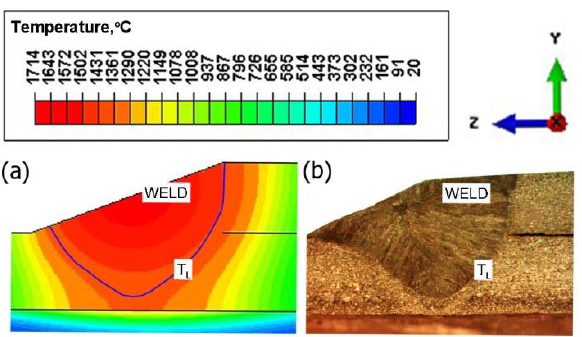
Figure 16. Temperature profile of welded pipes for two simulation times, t = 7 s; t = 17 s.